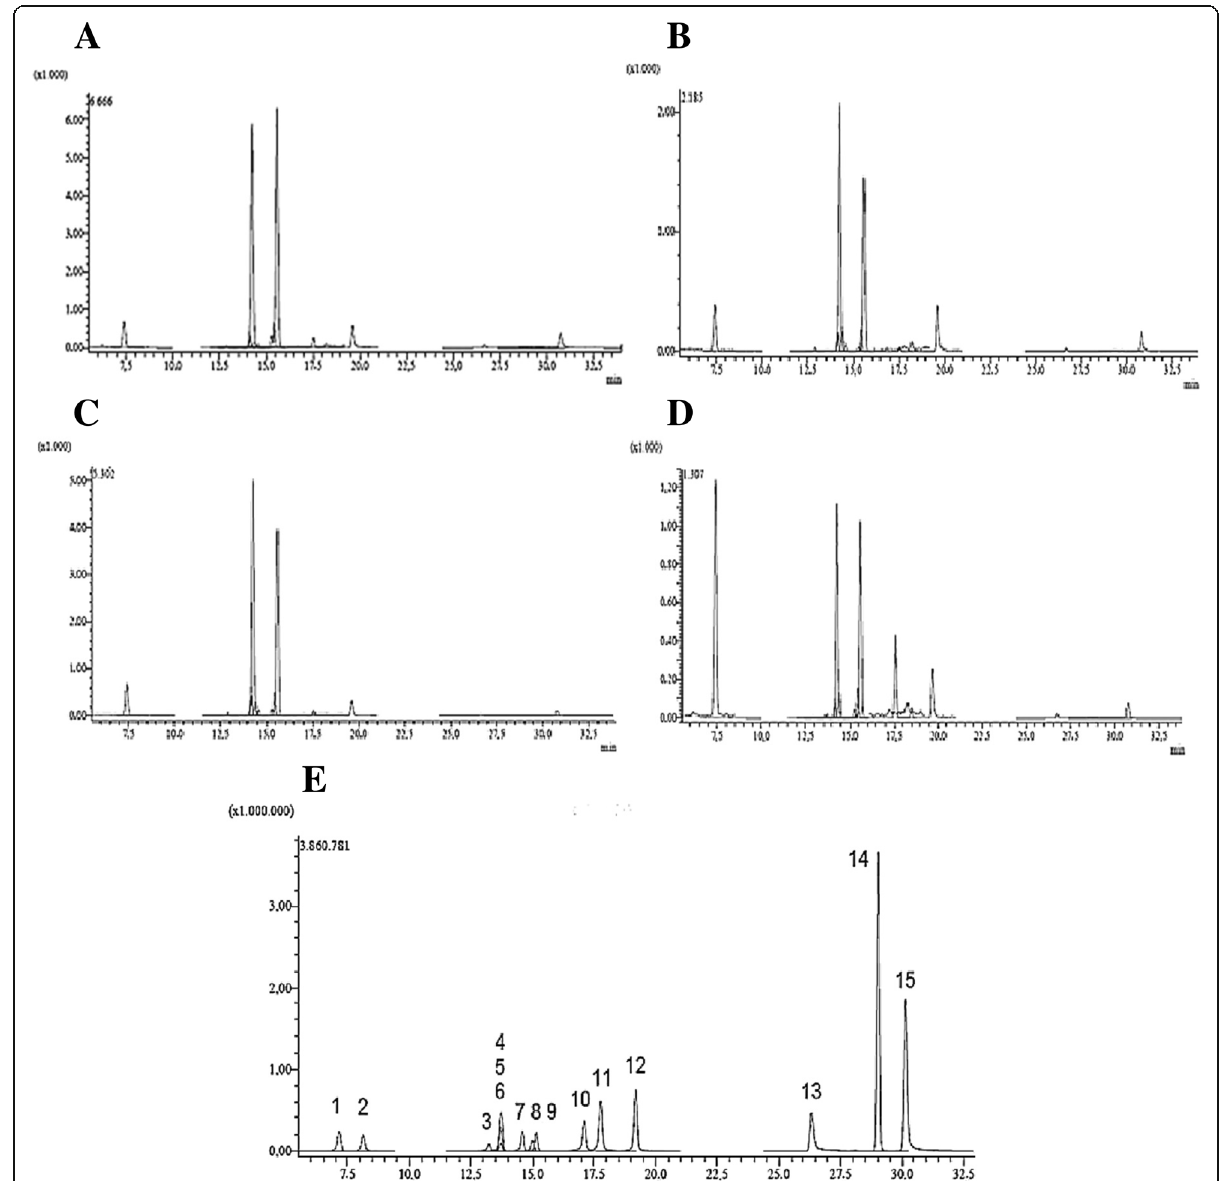
Fig. 5 Analytical parameters, identification, and quantification of phytochemicals of Q. infectoria gall extracts by LC-MS/MS. a ethyl acetate, b n- butanol, c ethanol, d aqueous extract, e LC-MS/MS chromatogram of 15 phytochemical standards. 1) Protocatechuic acid, 2) Chlorogenic acid, 3) Luteolin-7-glucoside, 4) Rutin, 5) Hesperidin, 6) Hyperoside, 7) Apigetrin, 8) Quercitrin, 9) Astragalin, 10) Quercetin, 11) Luteolin, 12) Apigenin, 13) Pseudohypericin, 14) Hyperforin, 15)